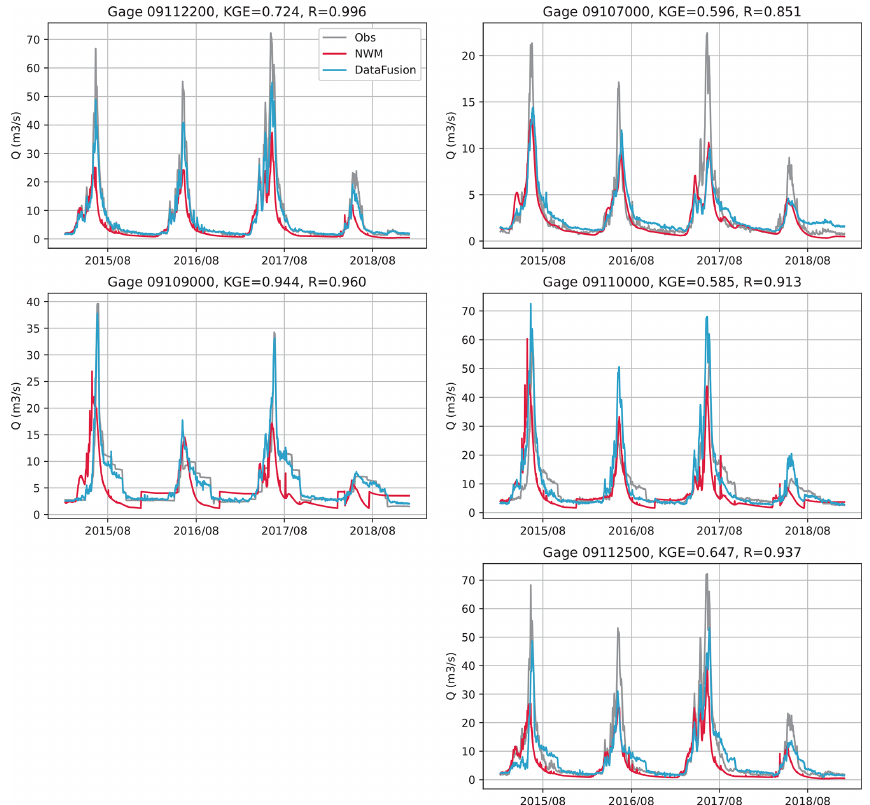
Figure 8. Hydrographs simulated by the NWM (dark red) and corrected GWN-O (data fusion, light blue) vs. the USGS data (observations (Obs), gray) over the testing period. KGE and R shown in the subplot titles are calculated between data fusion and observations.